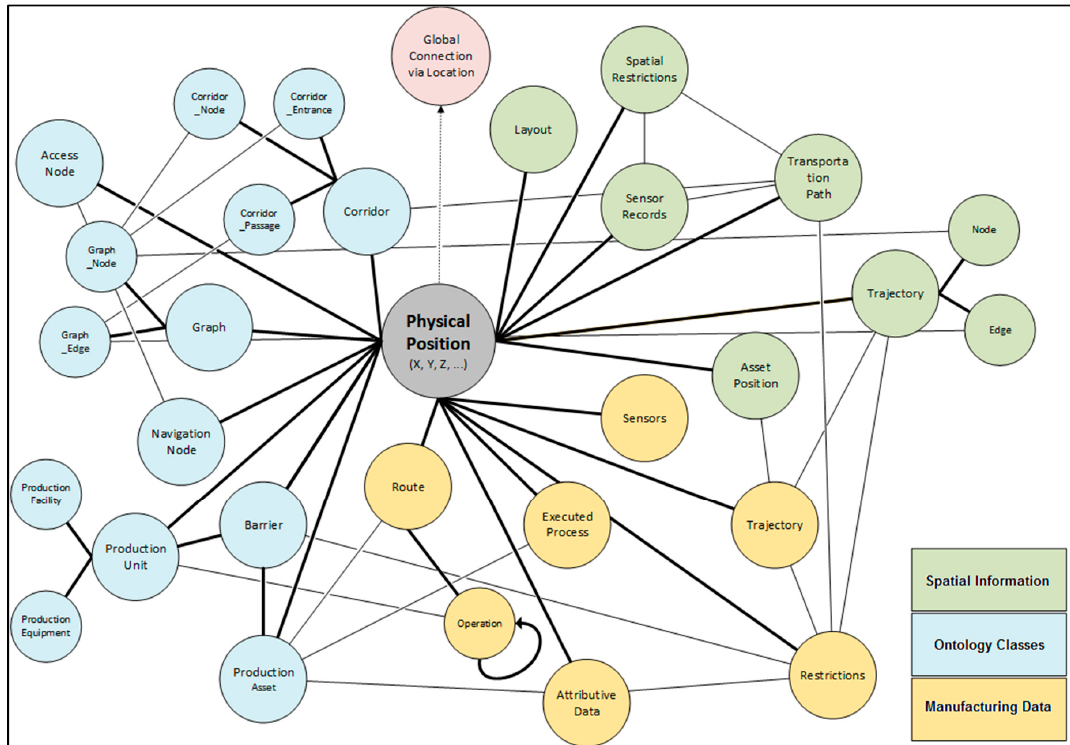
Figure 2. Linked Manufacturing Data for Transportation Tasks according to studies [3,41] at an abstract top level. Thick styled links represent the hierarchical structure of linked data, whereas thin styled links represent data links between different data sources.